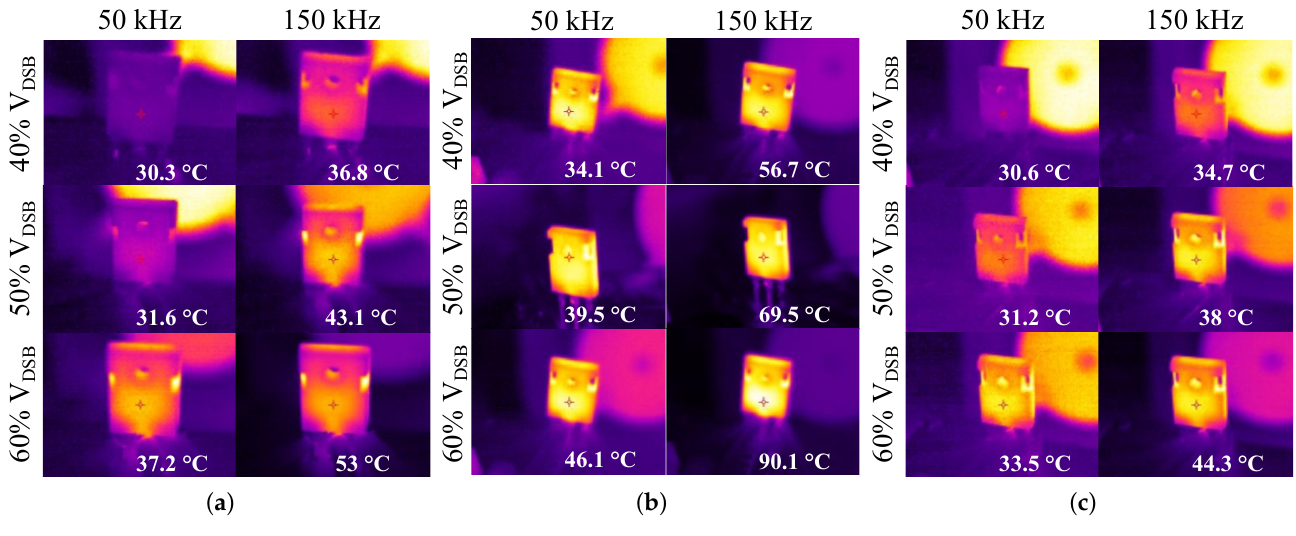
Figure 2. Measured temperatures for F SW = 50 kHz and 150 kHz, V DS = 40%, 50% and 60% of V DSB : ( a ) MTW20N50E, ( b ) IPW60R040C7 and ( c )